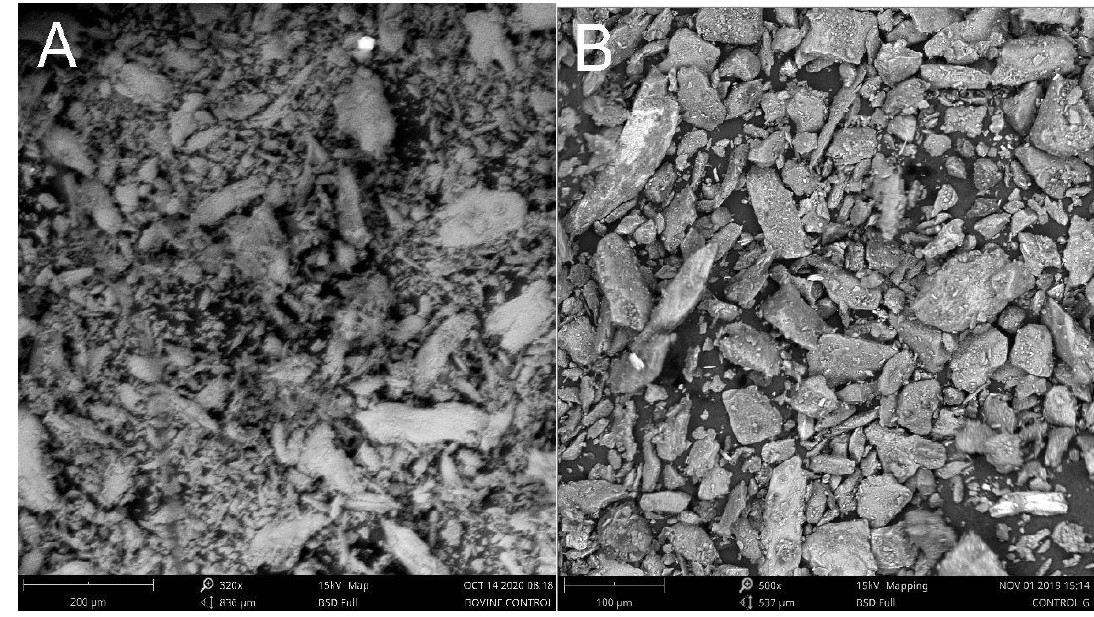
Fig. 6. The SEM Morphology of raw powder of (A) bovine bone (B) caprine